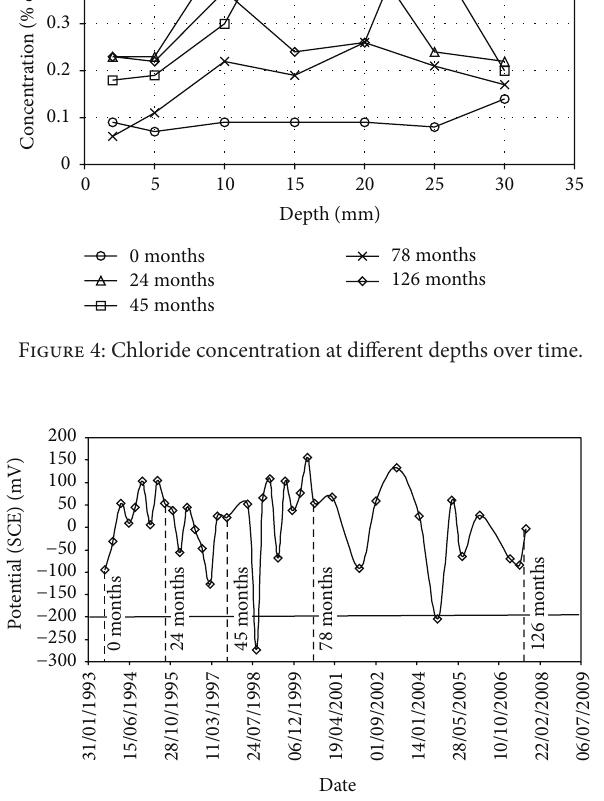
Figure 5: Corrosion potential over time; values below − 200mV indicate probable steel